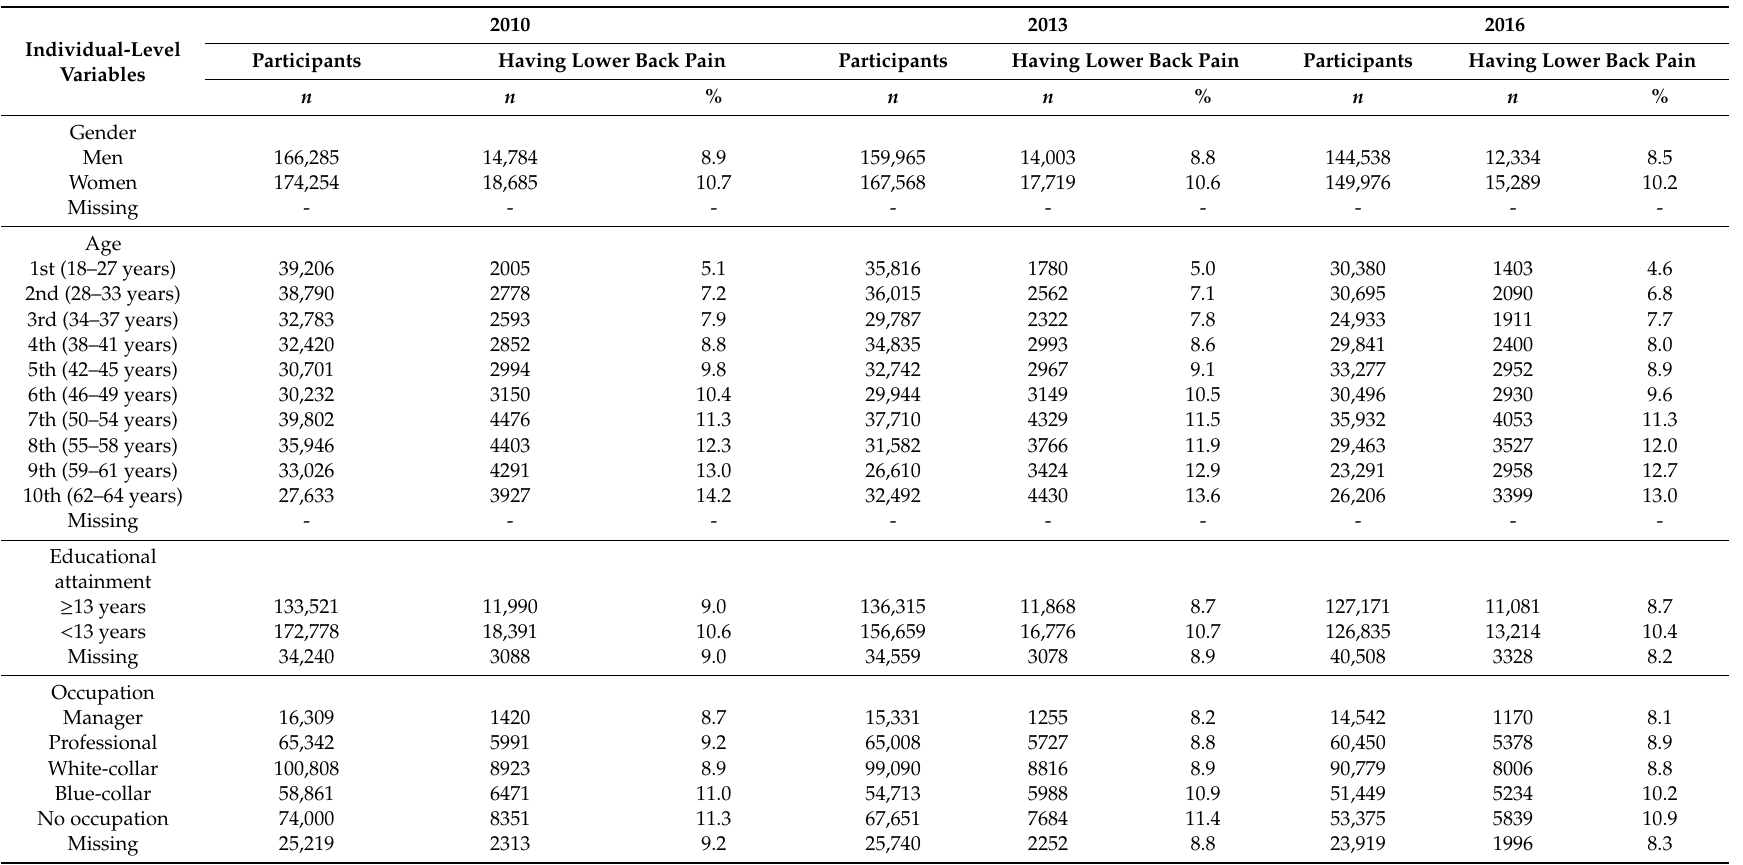
Table 1. Individual-level variables and lower back